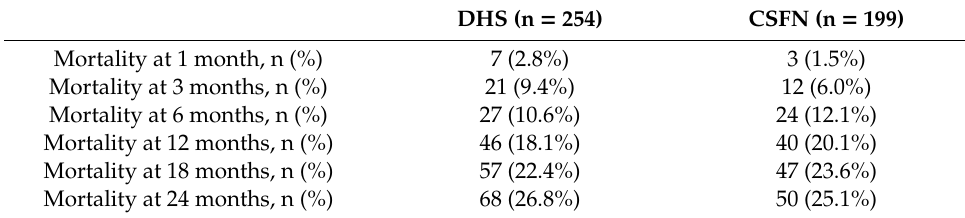
Table 3. Mortality for all patients throughout the 24-month observation